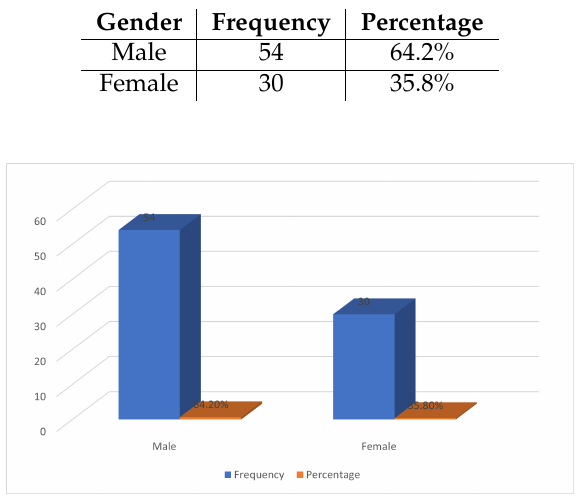
Table 1. Patients distribution